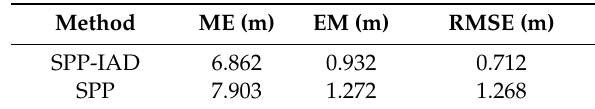
Table 4. Statistical results of positioning errors. ME, maximum error; EM, error mean; RMSE, root mean square error.